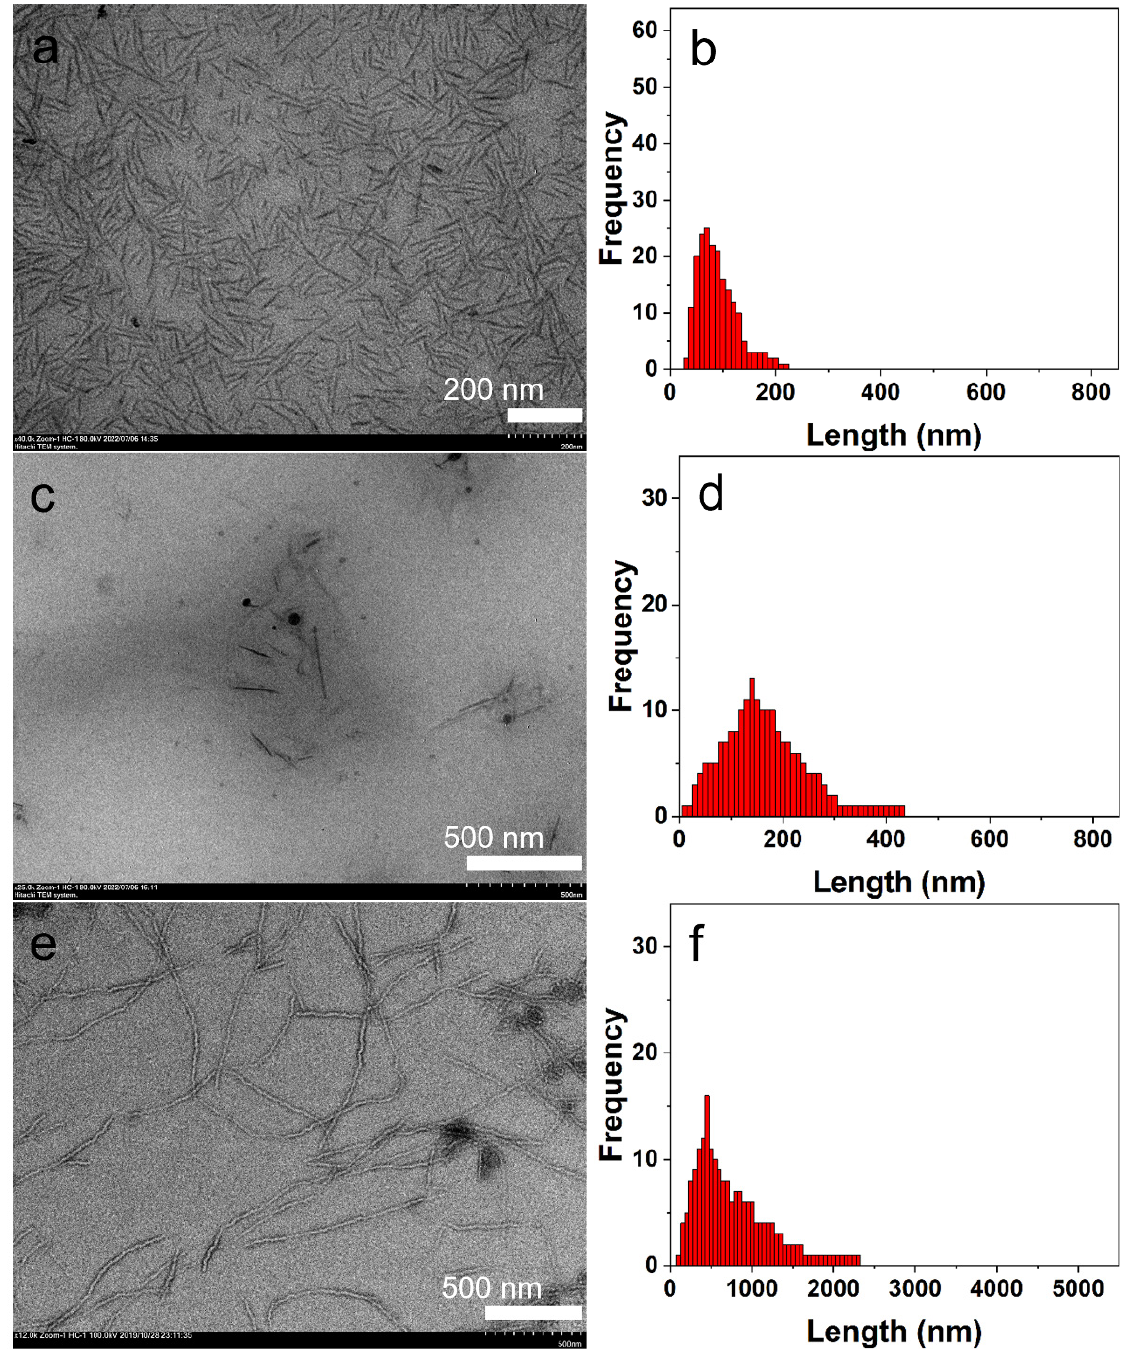
Figure 7. The TEM images and size distributions of the fibers self-assembled by P3HT 22 - b -PEG 113 in different solvents at c = 0.015 mg . mL − 1 . The TEM images of the fibers in methanol ( a ), ethanol ( c ), and isobutanol ( e ). The length distributions of the fibers in methanol ( b ), ethanol ( d ), and isobutanol ( f ).